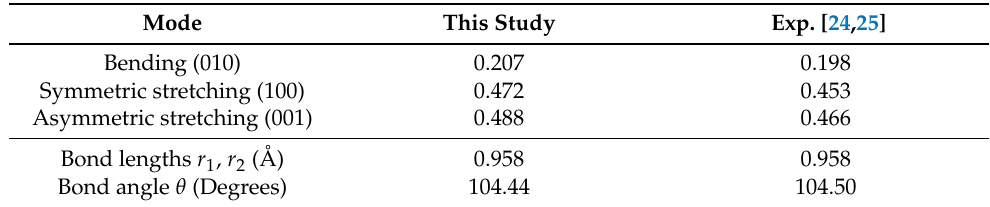
Table 1. The structure and vibrational frequencies (in eV) of H 2 O obtained in this study and compared with experimental data from ref.